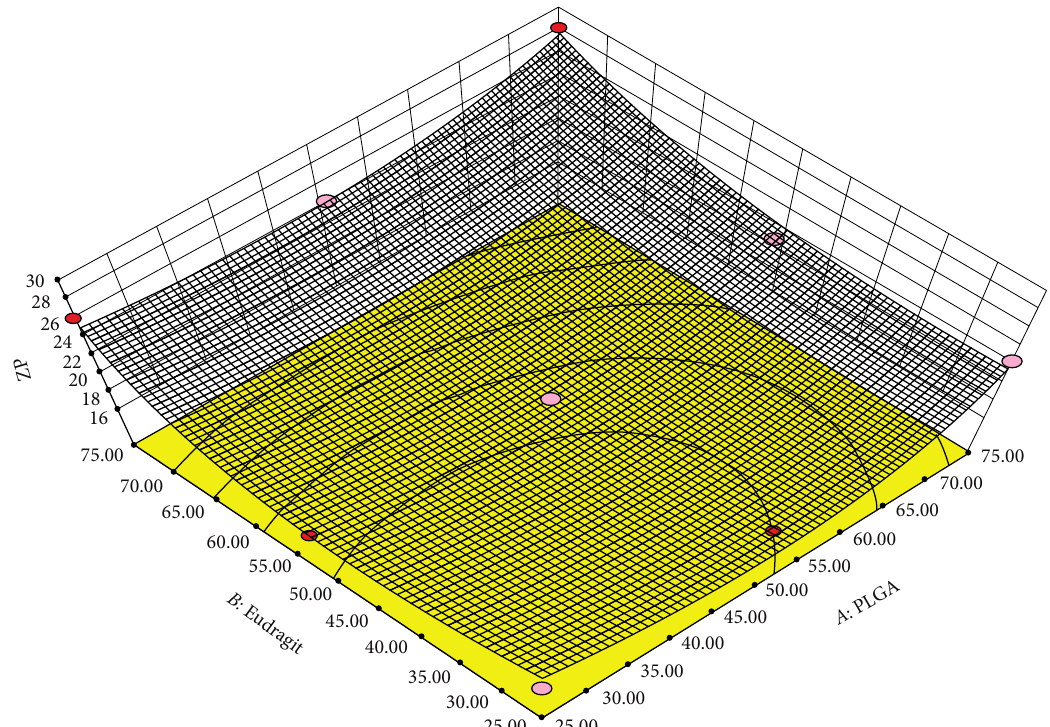
Figure 2: Response surface plots for the A and B on zeta potential ( 𝑋 2 ), where A PLGA concentration and B Eudragit RL100